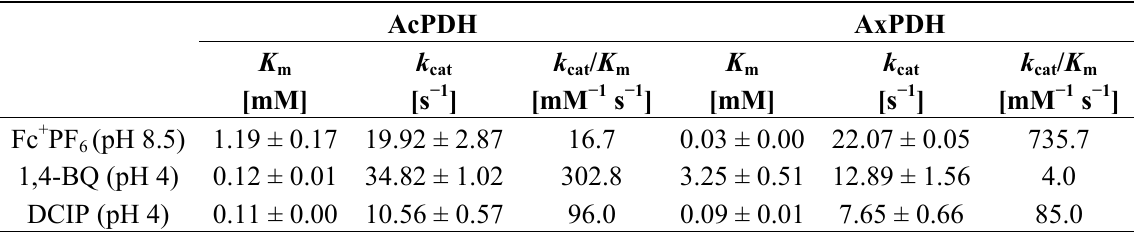
Table 4. Apparent kinetic constants for selected electron acceptors determined at 30 °C with 25 mM D -glucose as the electron